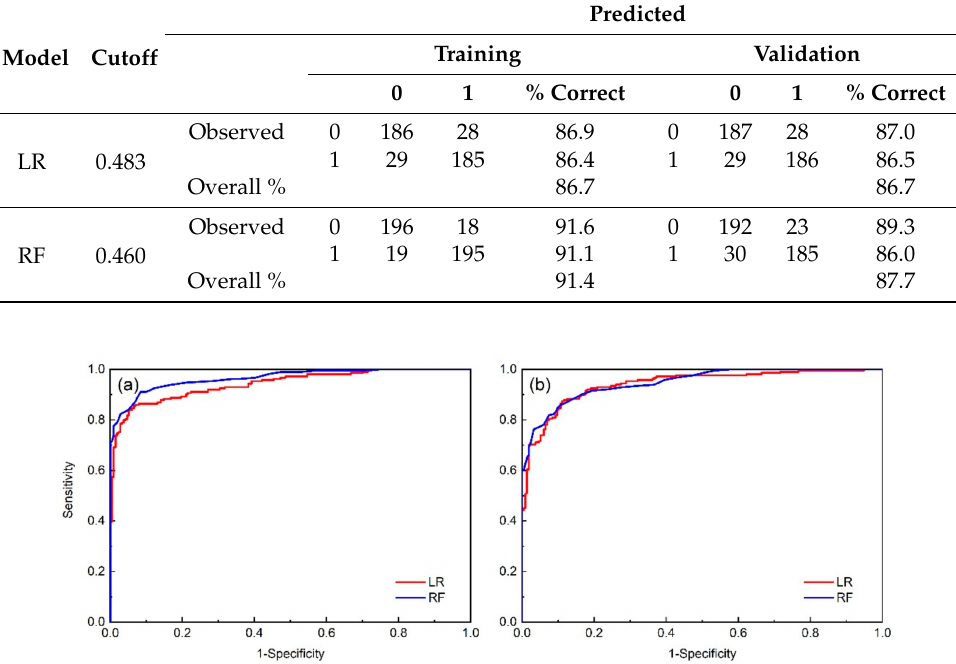
Table 3. Classification tables for the training and validation sets of data based on LR and RF models, with applied cut off values, according to the sensitivity equals specificity method.